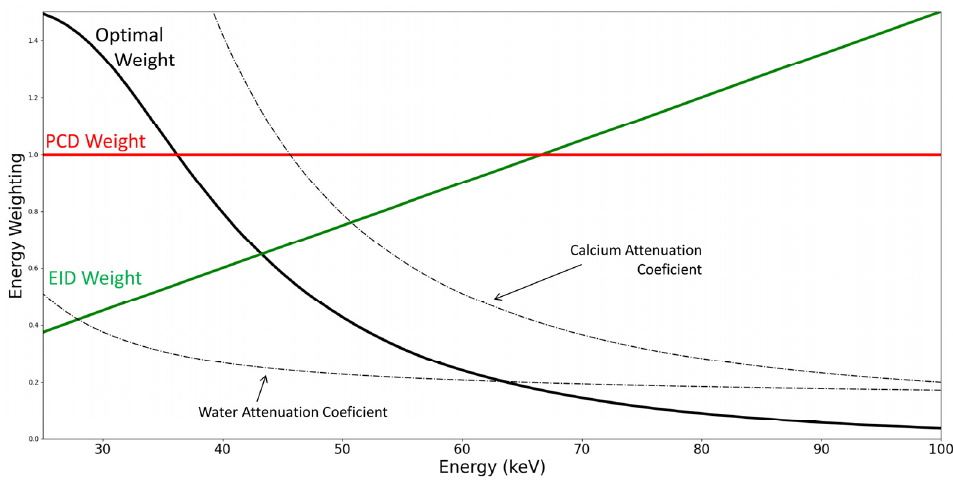
Figure 3. Energy weighting of energy integrating detectors (EID) and photon-counting detectors (PCD). The optimal weight for differentiating calcium from water is derived from the attenuation coefficients subtraction (dashed lines).